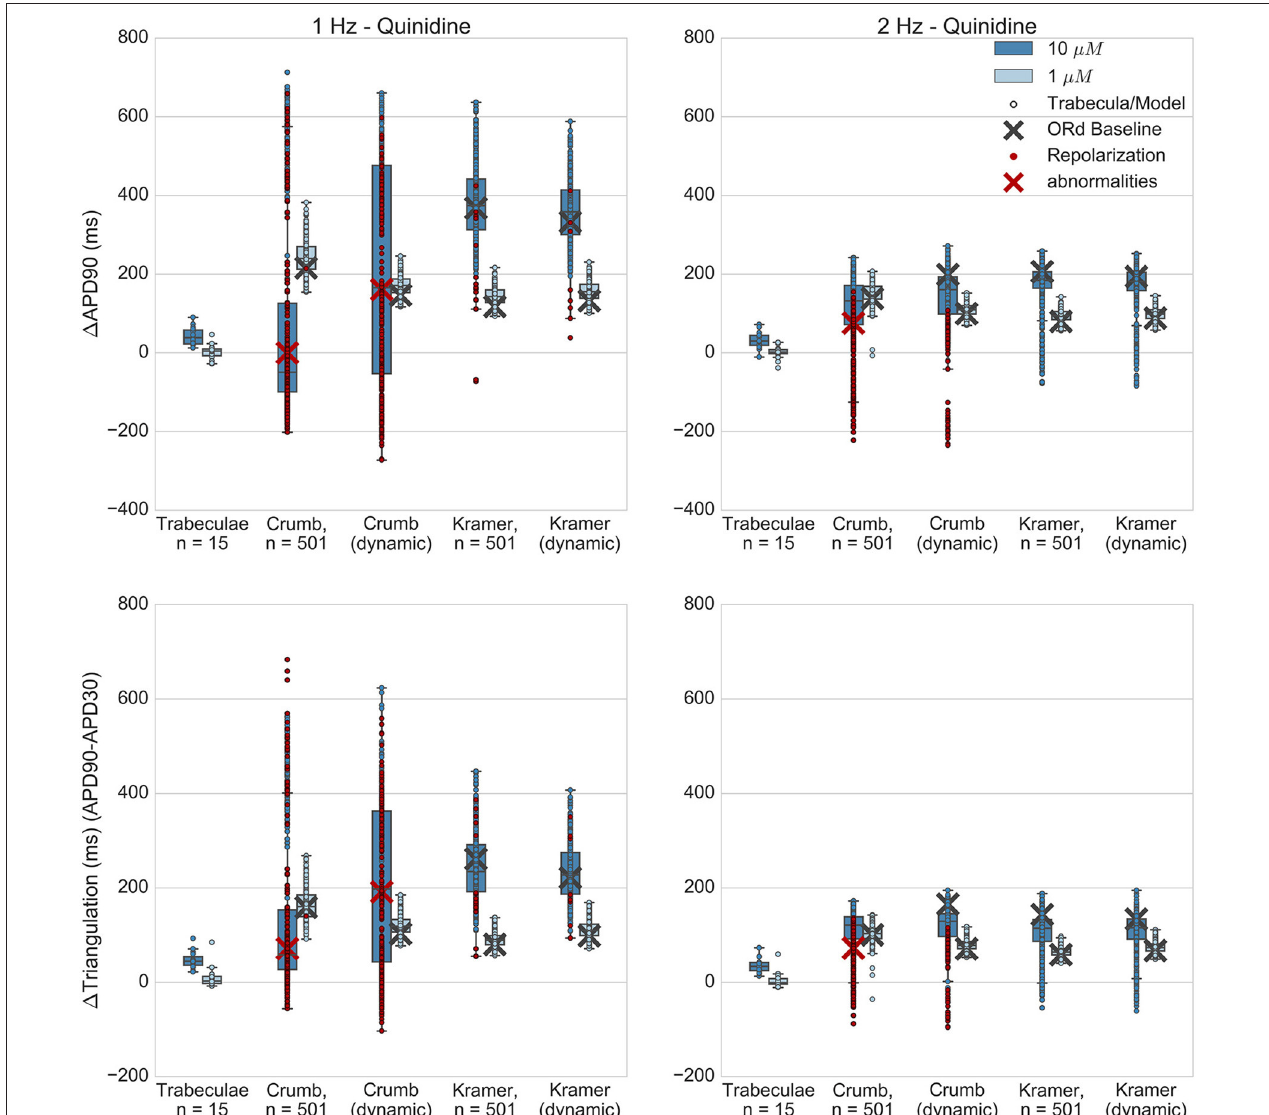
FIGURE 7 | Quinidine. Changes to APD90 and triangulation relative to control from application of 1 and 10 µ M quinidine during 1 and 2 Hz pacing. In each panel, response is shown for (left to right): human ventricular trabeculae, populations of models using drug effects calculated using data from Crumb et al. from Crumb et al. with I Kr replaced by the Li et al. I Kr model; from Kramer et al.; and from Kramer et al. with I Kr replaced by the Li et al. I Kr model. Dots indicate results from individual trabeculae and models, crosses show the result from the baseline ORd model. Red symbols indicate simulations and experiments where repolarization abnormalities